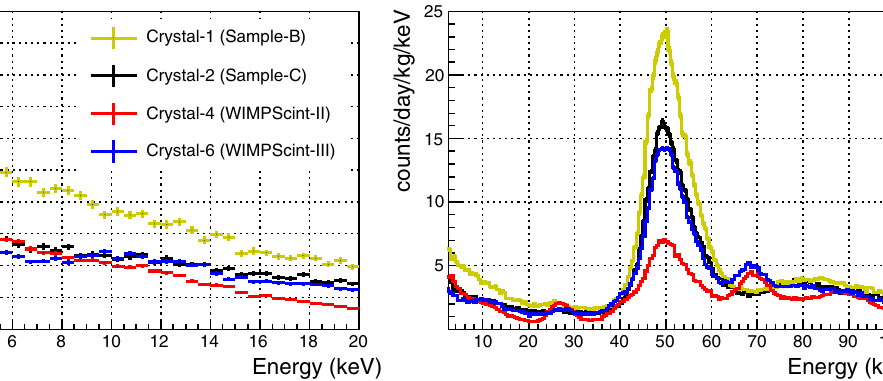
Fig. 20 Energy spectrum comparisons for four crystals from different powder samples. (left) A zoomed view of the E ≤ 20keV region of the spectrum.ThebackgroundlevelsarelowestforCrystal-4andCrystal-6, which reflect their lower 210 Pb and 40 K contamination levels. The spec- tra were made after the application of the three noise rejection criteria. (right) The peak near 50keV reflects the 210 Pb contamination level in